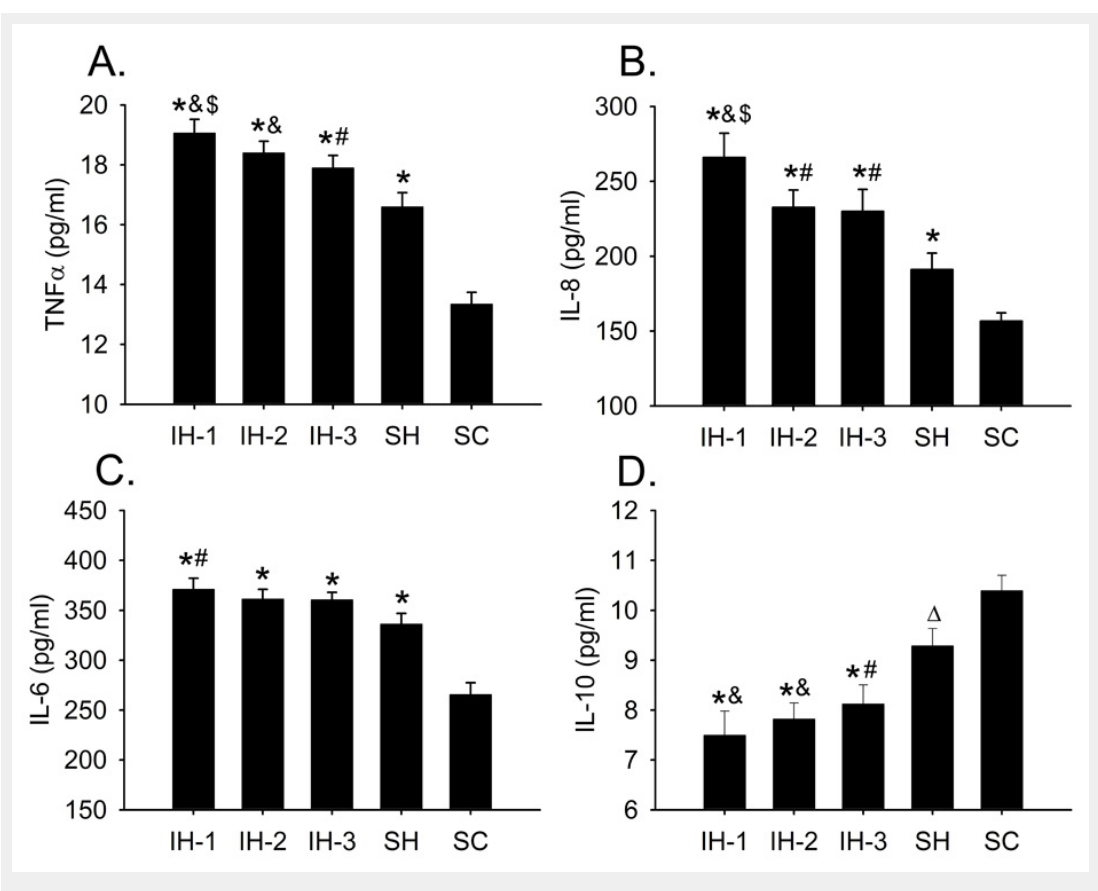
Figure 3 Comparison of serum levels of inflammatory cytokines at the 6 th week under intermittent hypoxia. Serum levels of TNF-α (A), IL-8 (B), IL-6 (C), and IL-10 (D) at the 6 th week of the hypoxic treatment were re-plotted as bar graphs for comparison among different groups. * P =0.01 compared with SC group; ∆ P =0.05 compared with SC group; # P =0.05 compared with SH group; & P =0.01 compared with SH group; & P =0.05 compared with IH-3 group, n = 7 or 8 in each